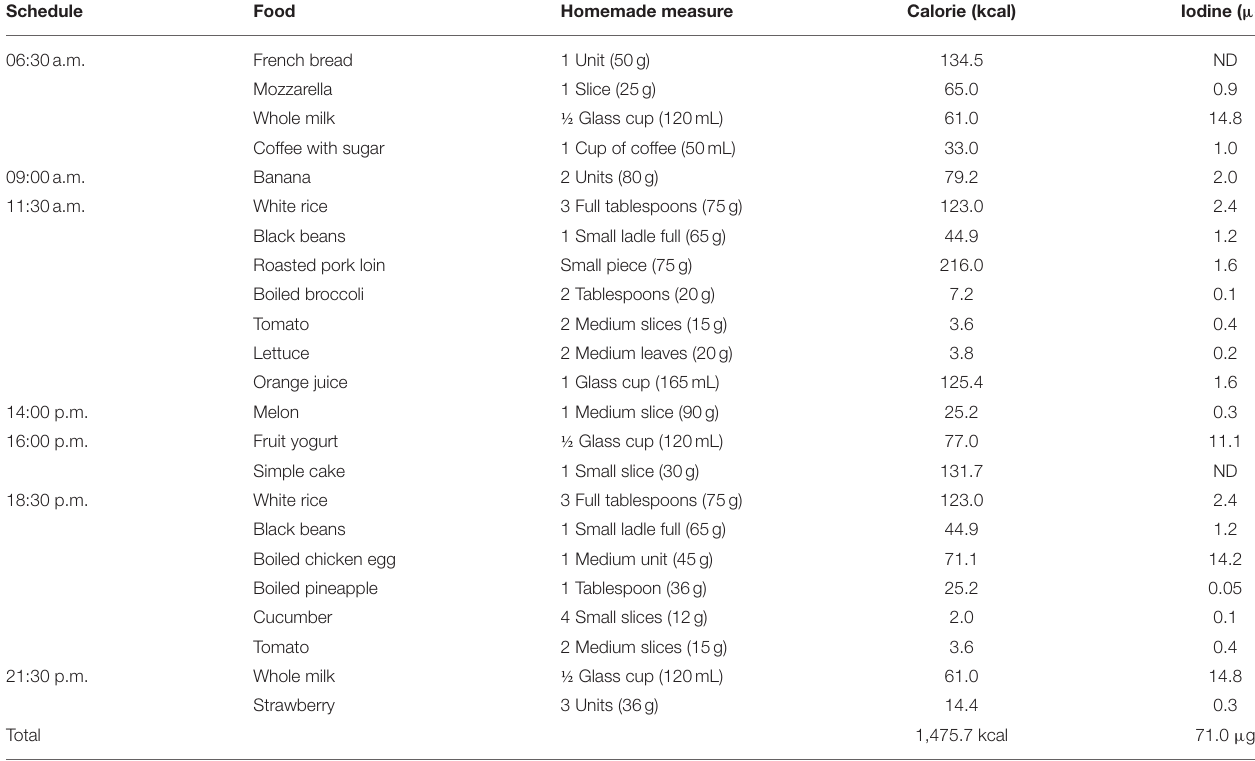
TABLE 2 | Food plan for a